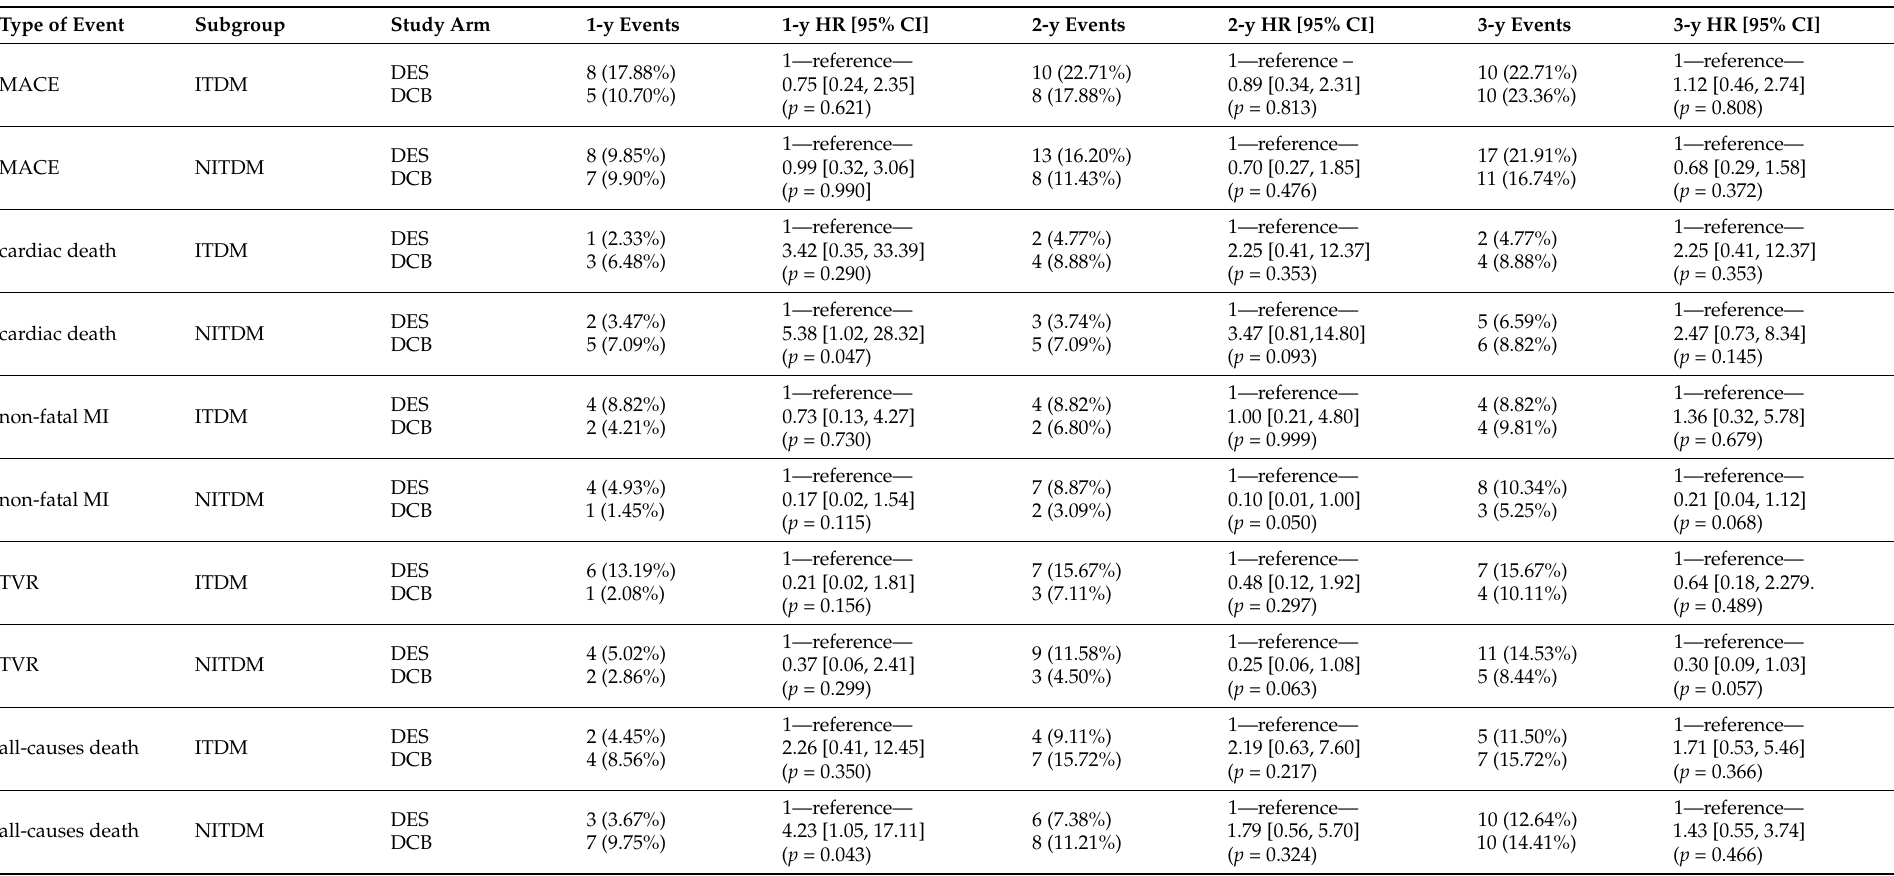
Table 2. Comparison of event numbers and Kaplan–Meier estimates of event rates between the two study arms within each subgroup for all